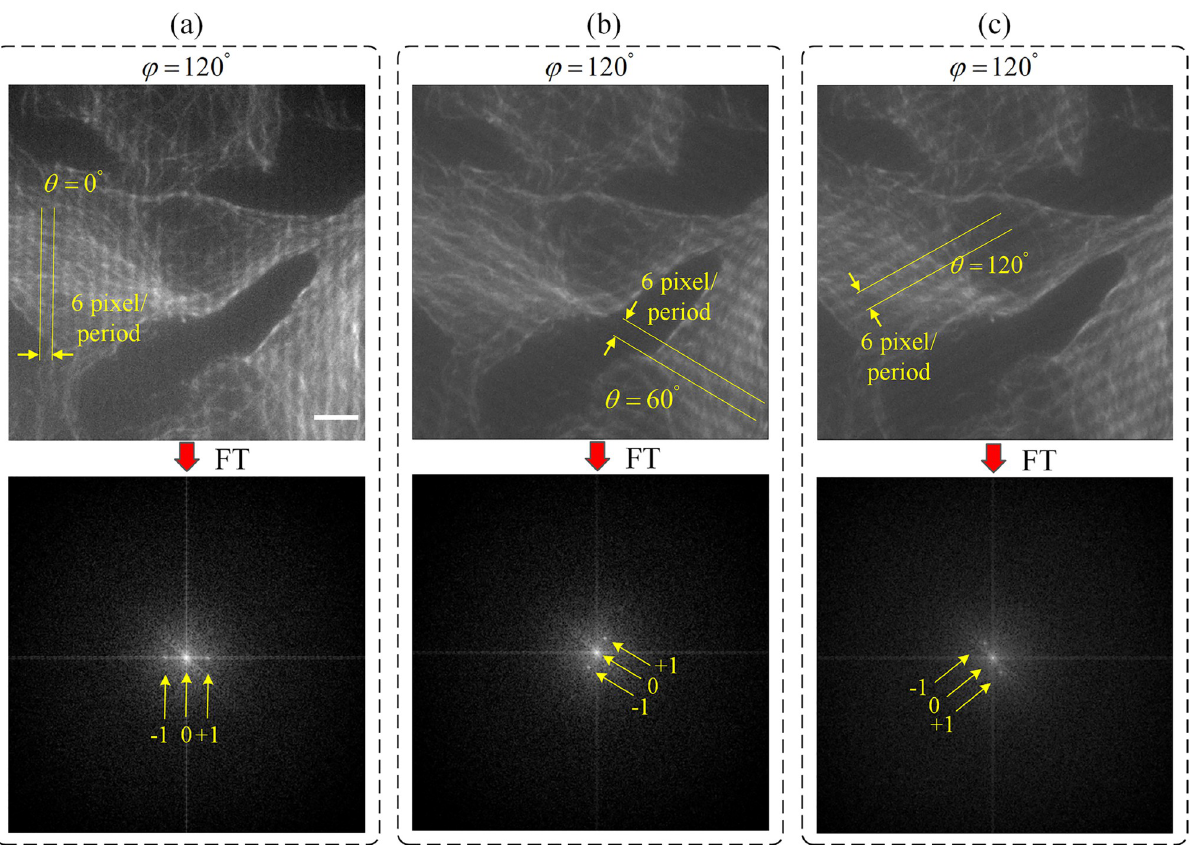
Fig 8. Cos7 cells were labelled with anti-tubulin and secondary Alexa-488. Raw fluorescence images of microtubules modulated with sinusoidal illumination patterns with the same phase angle of φ = 120˚, and three different orientation angles of θ = 0˚, 60˚, are shown in (a), (b), and (c), respectively. Bottom row shows the frequency spectra of the corresponding raw images at the top row. Scale bar indicates 5 μ